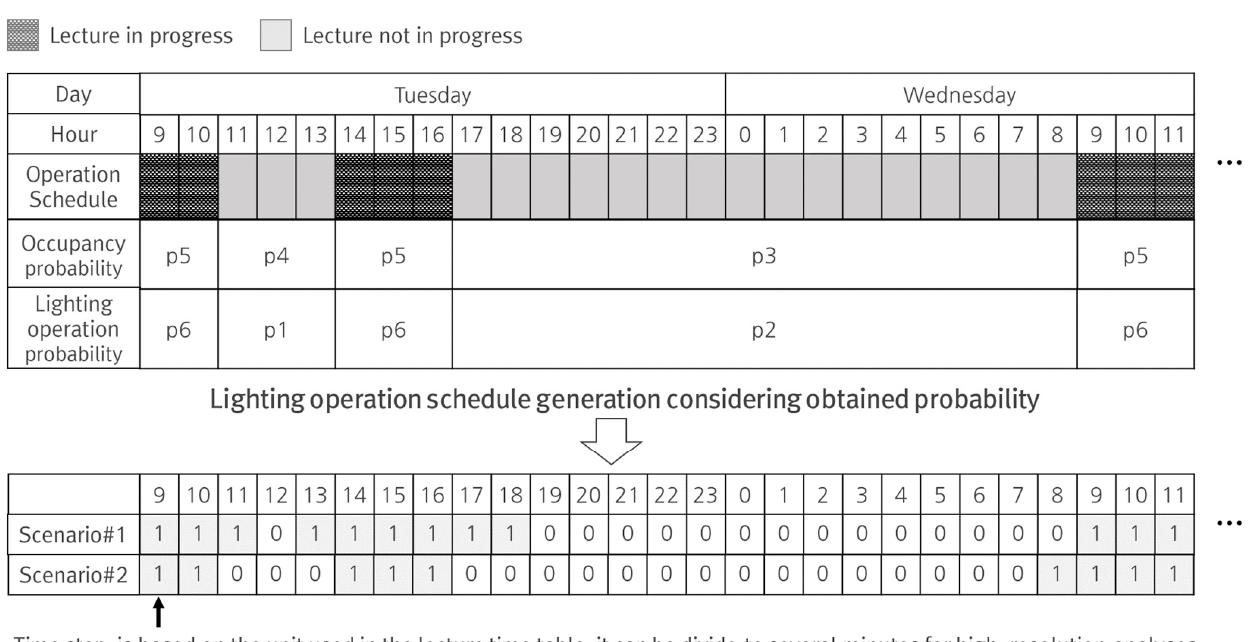
Figure 2. Probabilities for the occupancy and lighting operation.